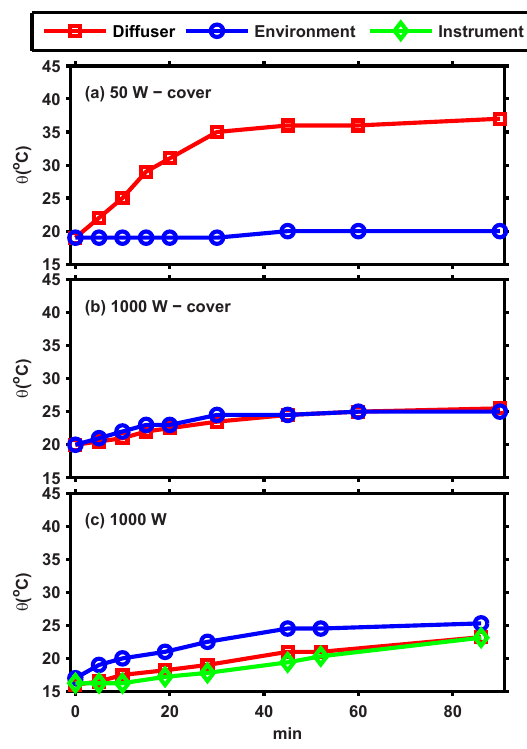
Figure 2. Change of the temperature of the diffuser of B005 (a) when a 50W lamp is placed at a vertical distance of 5cm above the diffuser and only the cover is used, (b) when a 1000W lamp is placed at a vertical distance of 50cm above the diffuser and only the cover is used, and (c) when a 1000W lamp is placed at a vertical distance of 50cm above the diffuser and the instrument is operating normally (the instrument is inside the